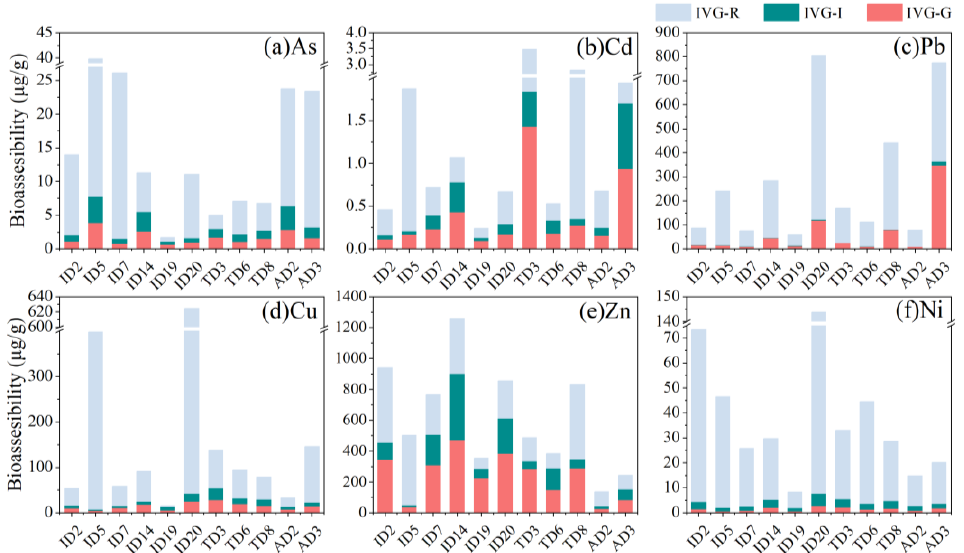
Figure 5. Bioaccessible trace metal concentrations in the simulated gastric (IVG-G) and intestinal (IVG-I) phases using the in vitro gastrointestinal (IVG) method for road dust from the industrial park (ID), traffic intersection (TD), and agricultural field (AD) areas of Guangzhou. IVG-R was determined via subtraction from the pseudo-total digested result. Table 2. Noncarcinogenic risks of trace metals in road dust using total and bioaccessible content.